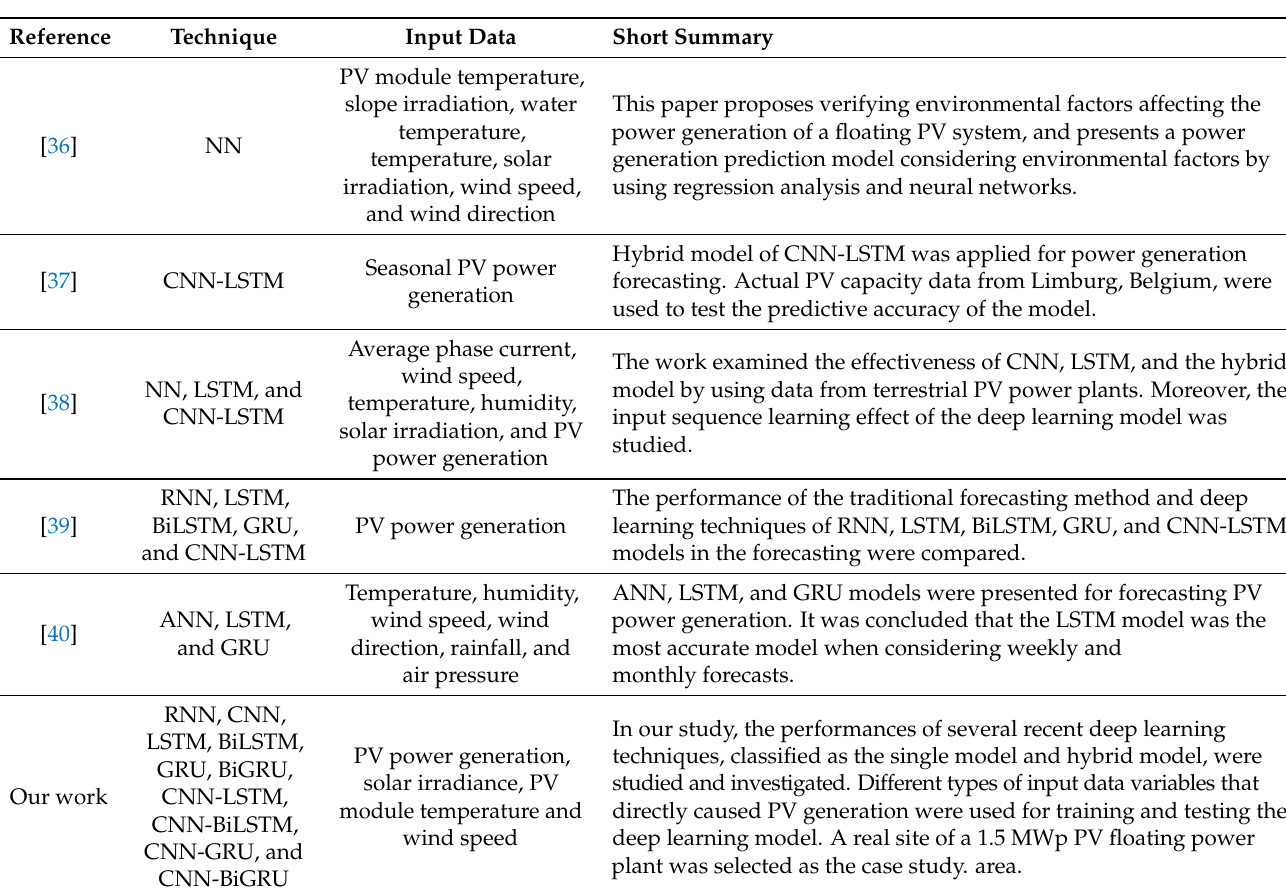
Table 1. Comparison with existing works.